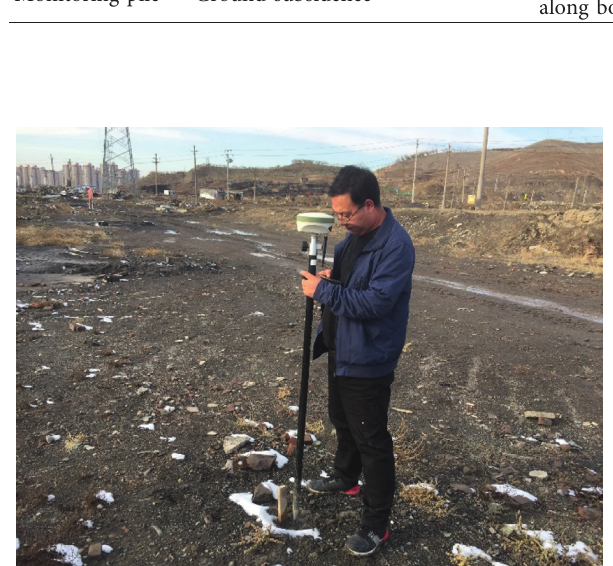
Figure 28: Monitoring pile and GPS.